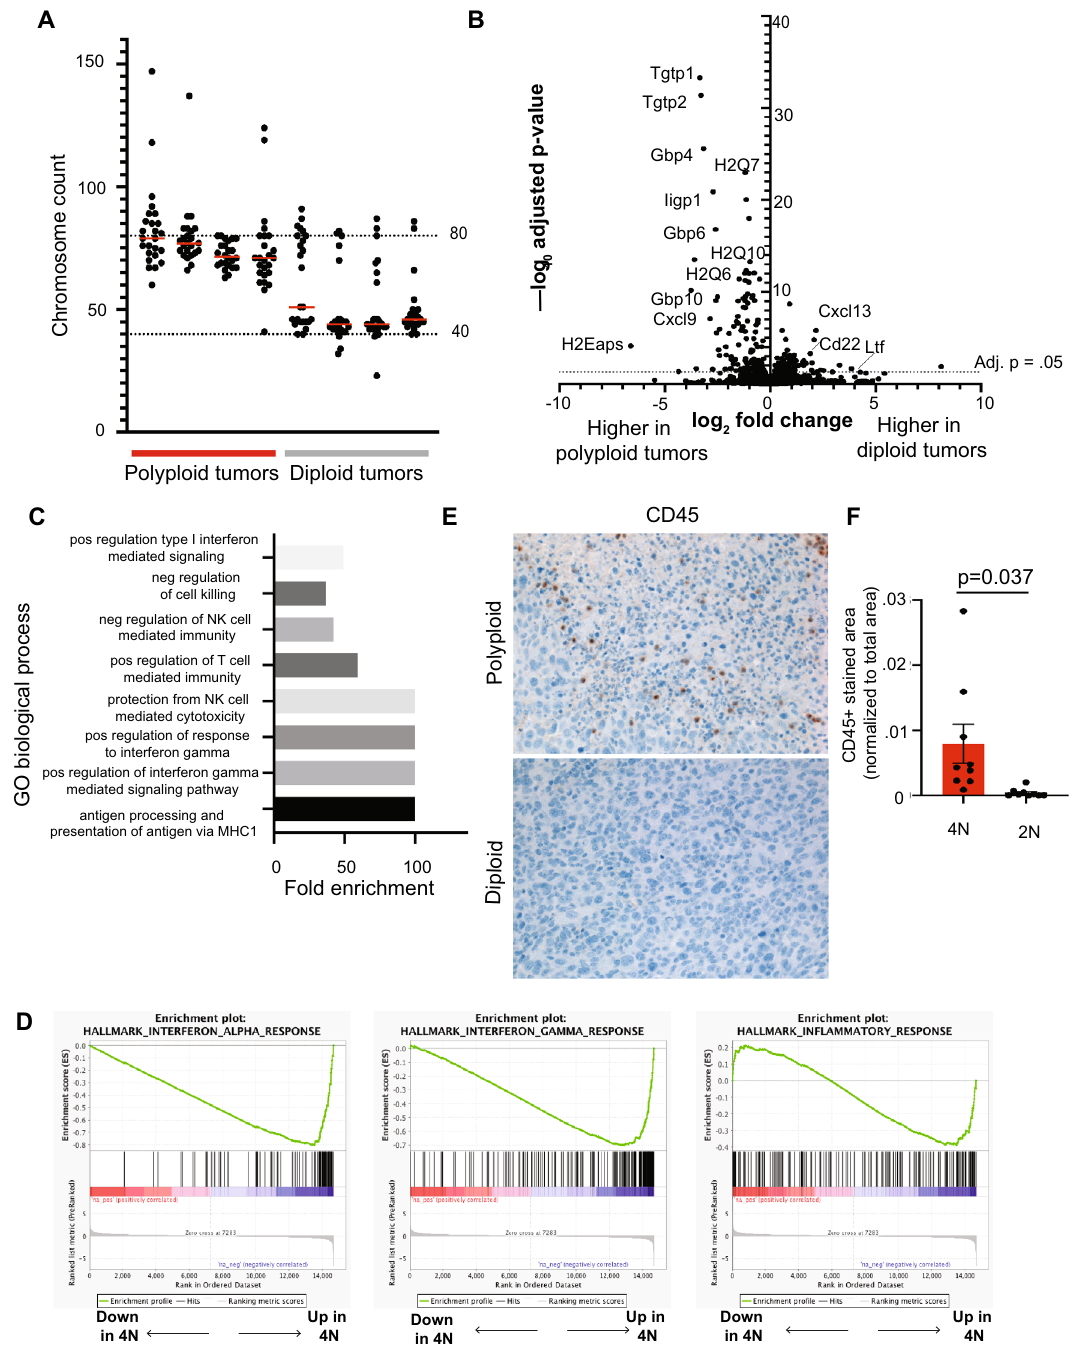
Figure 7. Polyploid primary tumors exhibit increased chromosomal instability and evidence of an innate immune response. ( A ) Chromosome counts from metaphase spreads performed on early passage diploid and tetraploid primary tumors. Red bars represent median chromosome counts. Dashed lines represent diploid and tetraploid chromosome counts. ( B ) Volcano plot showing differentially expressed genes between diploid and tetraploid tumors. Fold-change is shown on x-axis and adjusted p-value as determined by DESeq2 is shown on y-axis. The dotted line indicates an adjusted p value of 0.05. ( C ) Selected GO Biological Process terms from the top 50 significantly enriched in tetraploid tumors (FDR < 0.05). ( D ) Selected gene sets enriched in tetraploid tumors by GSEA analysis (FDR q-value < 0.1). ( E ) Representative images of CD45 staining on diploid and WGD primary tumors. ( F ) Quantification of CD45 staining on diploid and WGD primary tumors. CD45 staining area is normalized to the total nuclear area. The mean and standard error of the mean are represented for each group. Significance was determined using Welch’s t-test. ( A – D and F ) were generated using Graph Pad Prism 9 software (version 9.0.0 (86) for Mac, https:// www. graph pad. com/ scien tific- softw are/